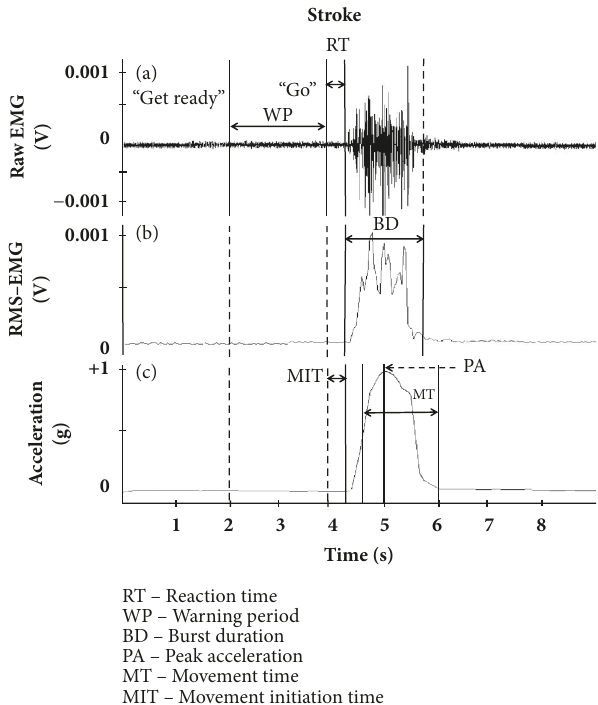
Figure 2: (a) Raw and (b) processed (filtered and rectified) EMG and (c) acceleration, sampled from the anterior deltoid during flexion-reaching, depicting variables of interest. Reaction time (RT) is the times between the final cue and the EMG onset. Burst duration is the time between start and end of EMG signal. Movement time (MT) was defined as the total time interval from the start to the end of the upper extremity movement, taken as the interval between the onset and offset of the acceleration signal. Peak acceleration (PA) was defined as the maximum amplitude of the acceleration signal along the X-axis of the sensor’s coordinate system. Movement initiation time (MIT) is the time after RT to the beginning of the acceleration